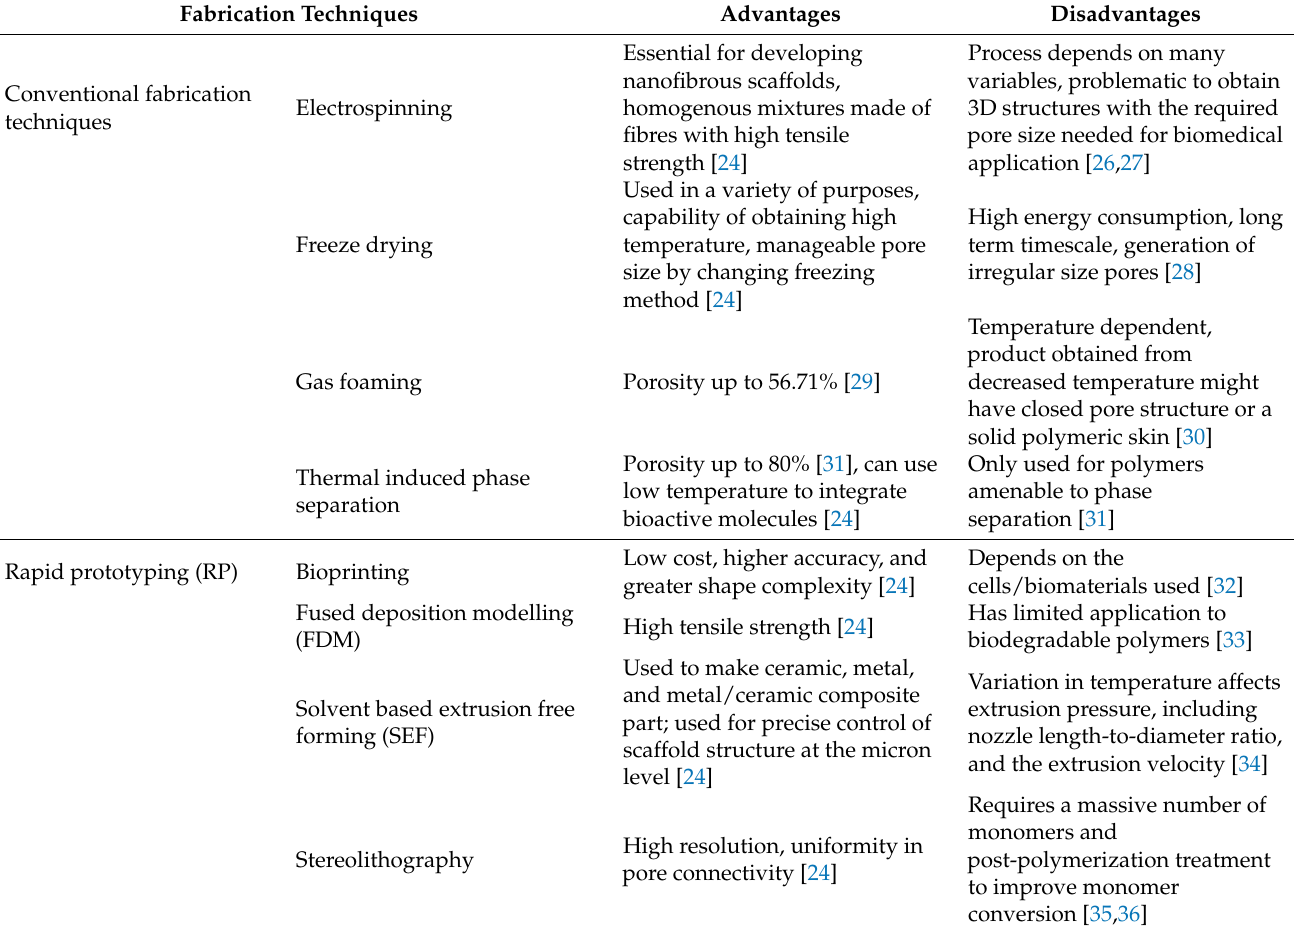
Table 1. Classification of scaffold fabrication techniques used in skin tissue